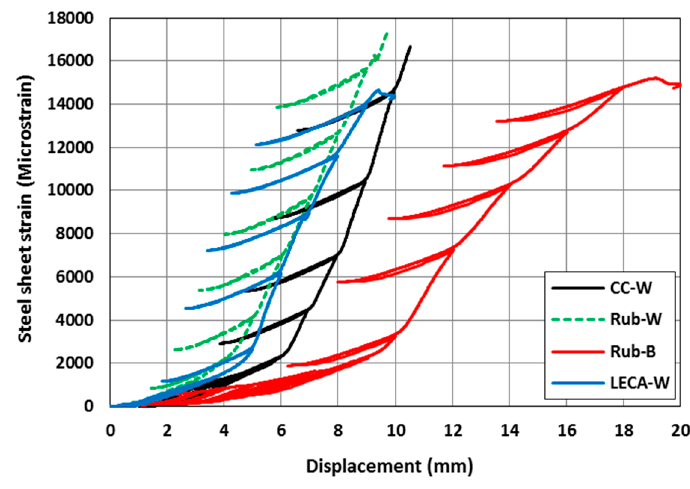
Figure 14. Displacement vs. bottom steel plate strain hysteretic curves for the tested specimens.